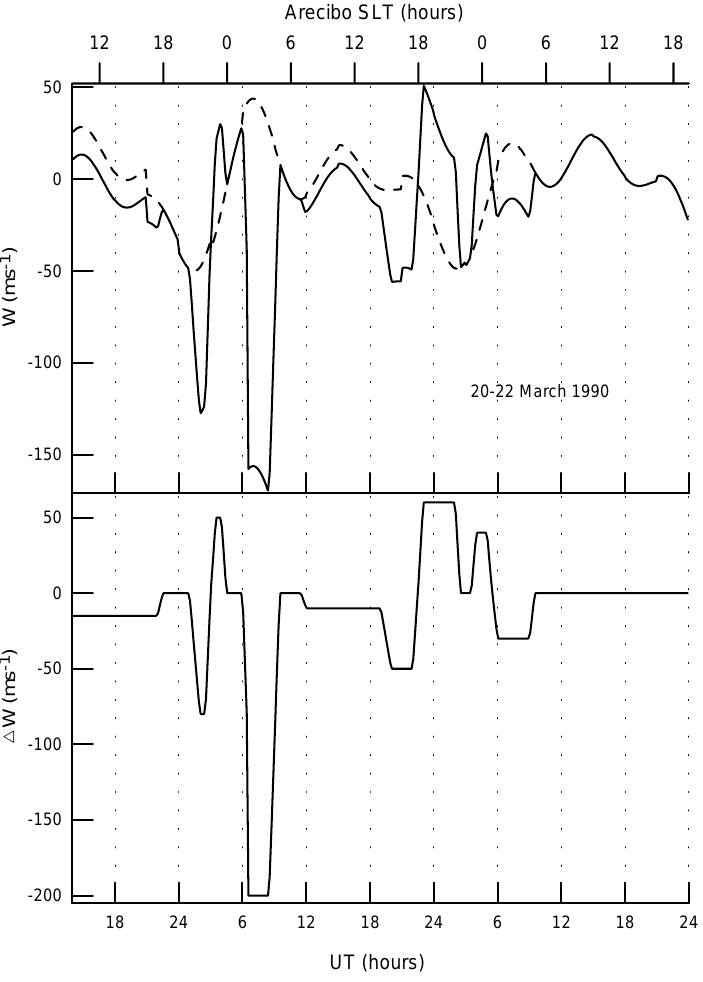
Fig. 13. Diurnal variations of the meridional neutral wind, W (top panel), and the additional meridional neutral wind, 1 W (bottom panel) during 20–22 March 1990 (when the original value of W is changed to W+ 1 W). The values of 1 W are used in the Northern Hemisphere above the geomagnetic latitude of 25 ◦ , while 1 W=0 at the geomagnetic equator. A square interpolation of 1 W is employed between 25 ◦ and 0 ◦ . The modeled meridional corrected and uncorrected HWM90 meridional neutral winds at 300-km altitude over the MU radar are shown in the top panel by the solid and dashed lines, respectively. The meridional wind is directed northward for W > 0 and southward for W <